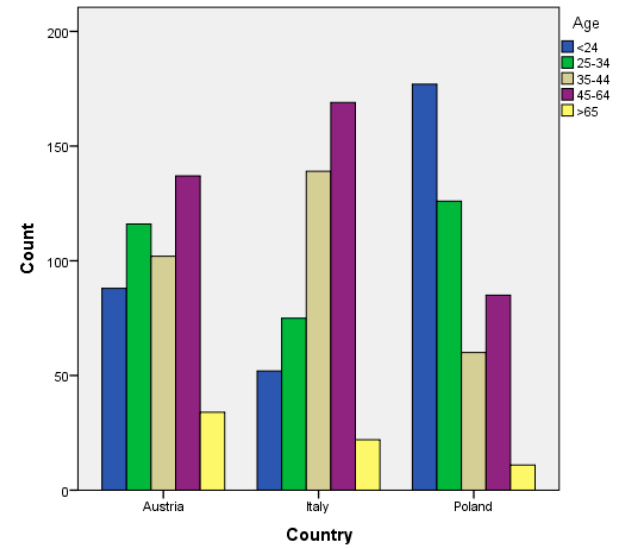
Figure 1. Age of the country samples.